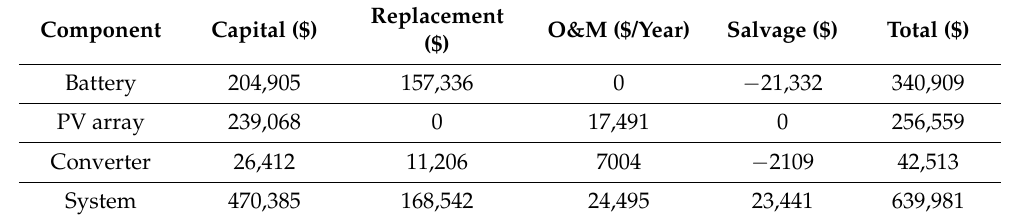
Table 10. Cost summary of the components for PV–BSS configuration.